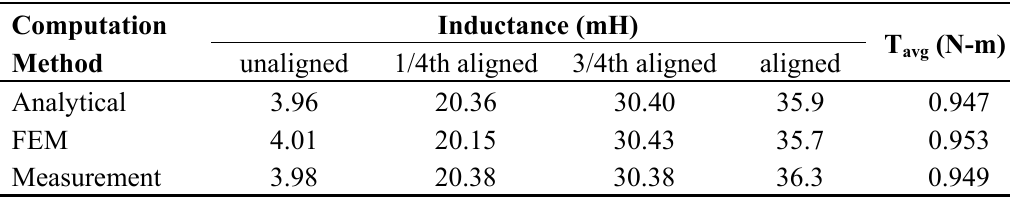
Table 2. Comparative